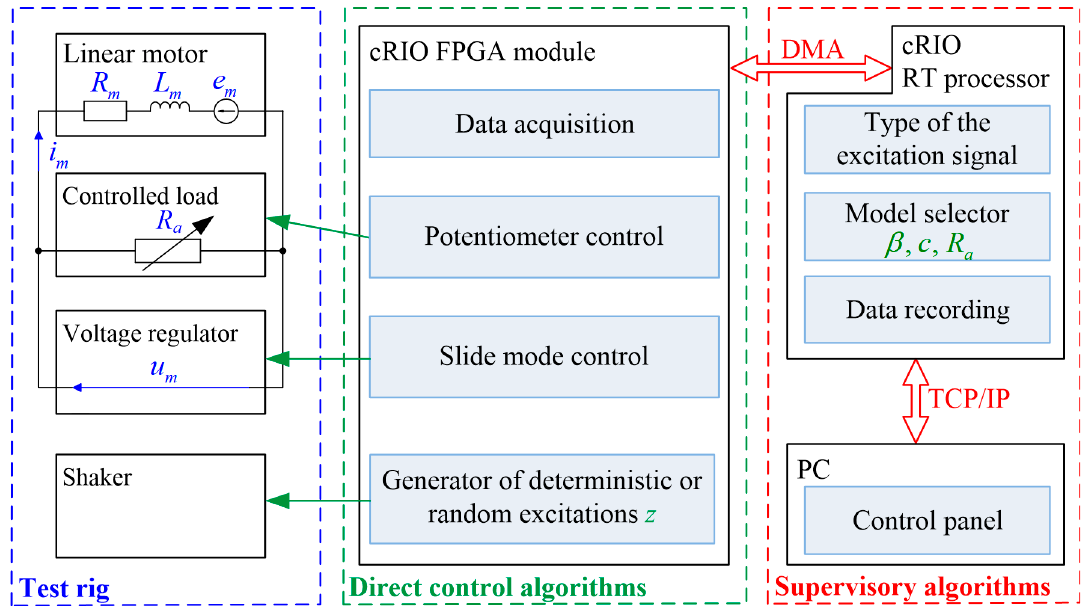
Figure 12. Block diagram of the control system—HVRS.